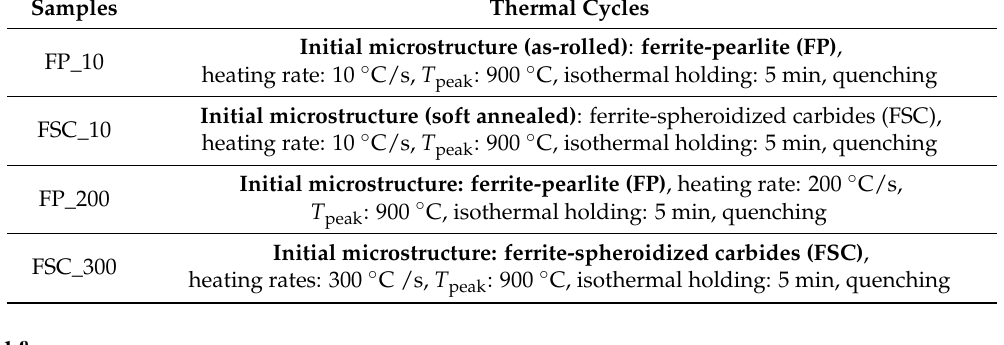
Table 2. Representation of four separate thermal cycles and microstructural characteristics for each one of the samples.